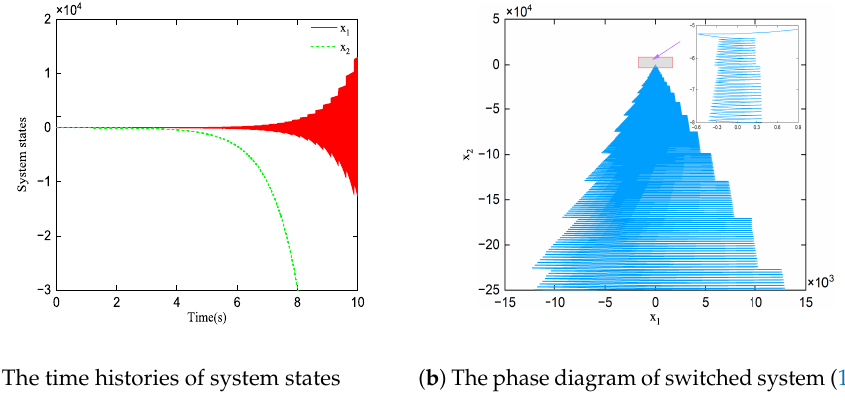
Figure 10. The switched system (15) is not stable under the switching rule ( 1 → 2 → 3 → 1 )